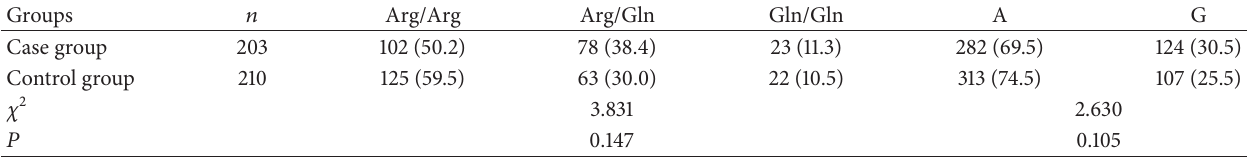
Table 1: Analysis of correlation between the XRCC1 Arg399Gln polymorphism and susceptibility to esophageal cancer ( 𝑛 (%)). Groups